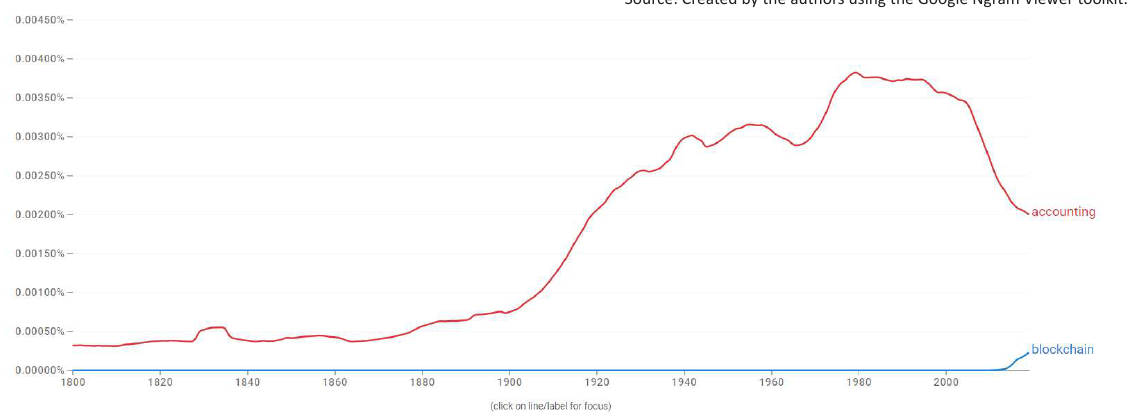
Figure 13. Mention frequency analysis of the blockchain and accounting concepts according to Google Books sources